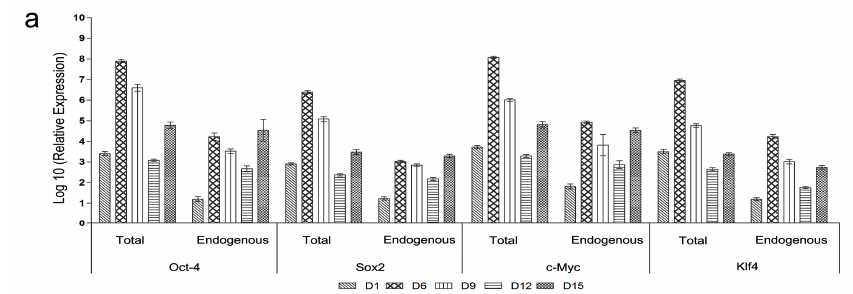
Figure 10. Changes in introduced factors and pluripotency markers during